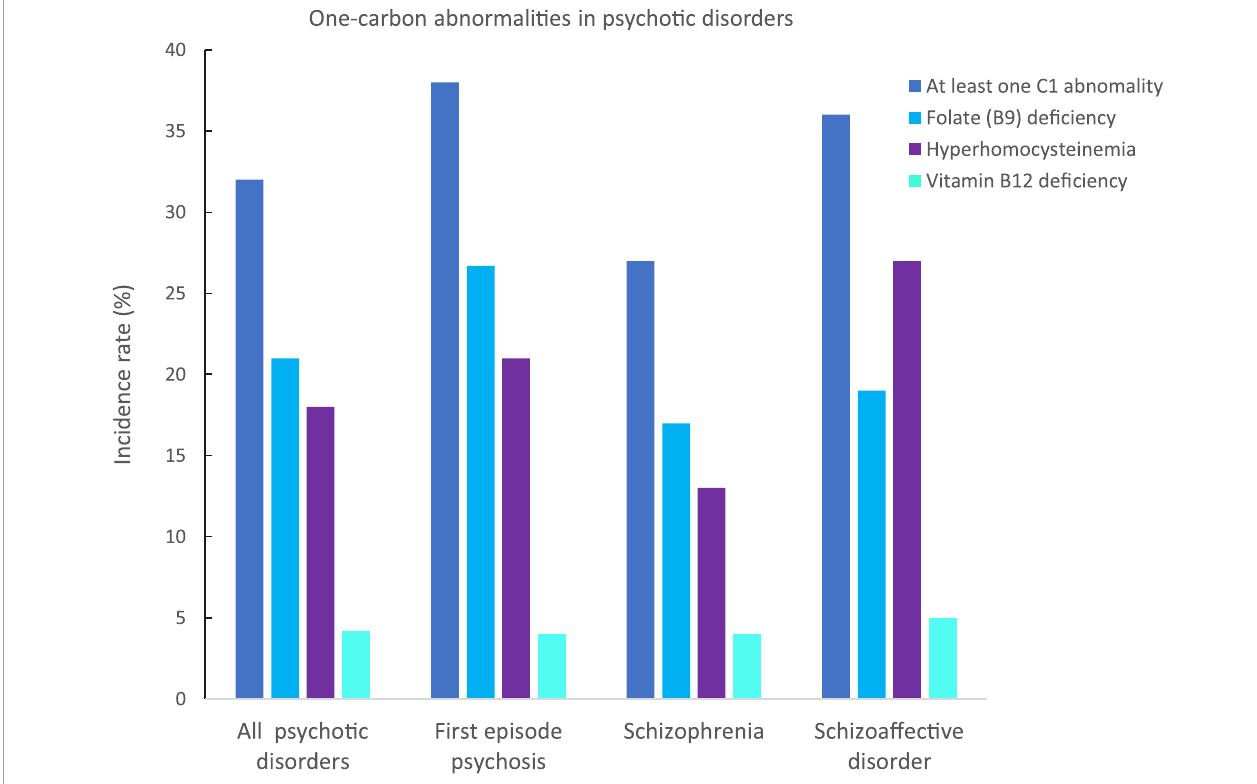
FIGURE1 Incidence rates of one-carbon (C1) abnormalities in our psychotic disorders sample. C1 abnormalities have been identified in deficiencies in folates (B9, in light blue), vitamin B12 (in cyan), and hyperhomocysteinemia (in purple). The incidence of at least one C1 in the whole sample was of 32%, 38% for first episode psychosis, 27% for schizophrenia, and 36% for schizoaffective